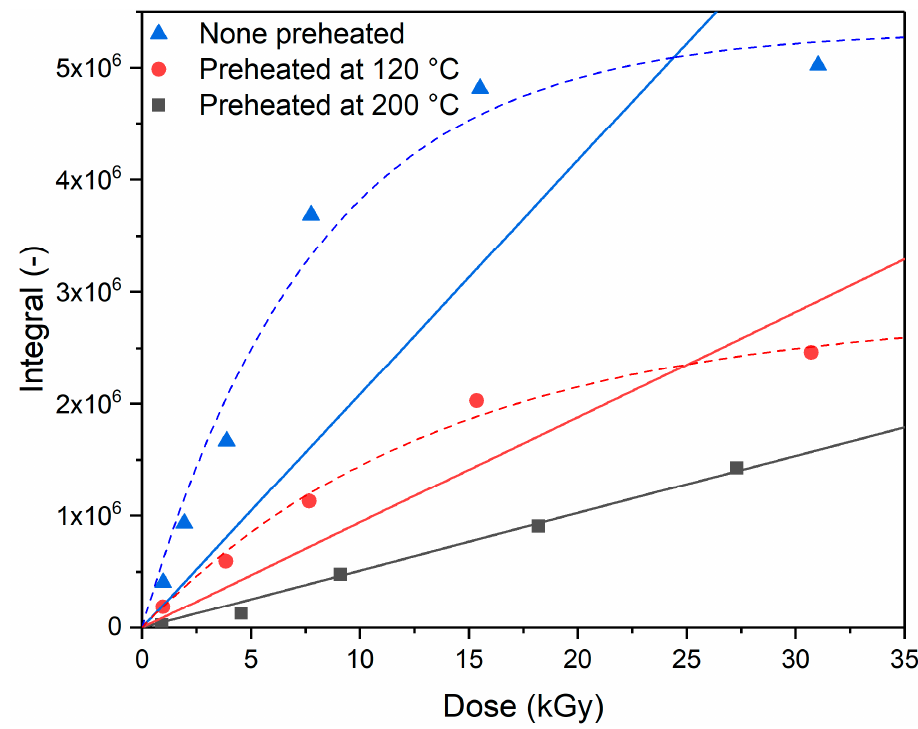
Figure 13. Dependencies of TL signal integral vs. dose absorbed for preheated PPG_Tb30 glass dosimeter irradiated with beta radiation (4 μ s pulse duration).